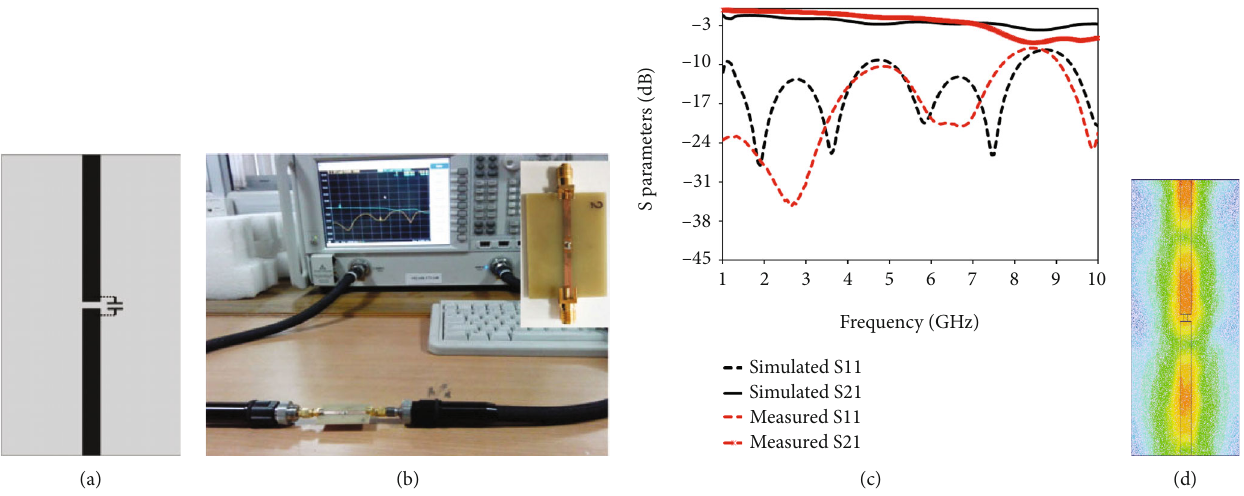
Figure 7: (a) Layout for RF bypass capacitor; (b) measurement setup; (c) S parameter vs. frequency; (d) fi eld distribution.